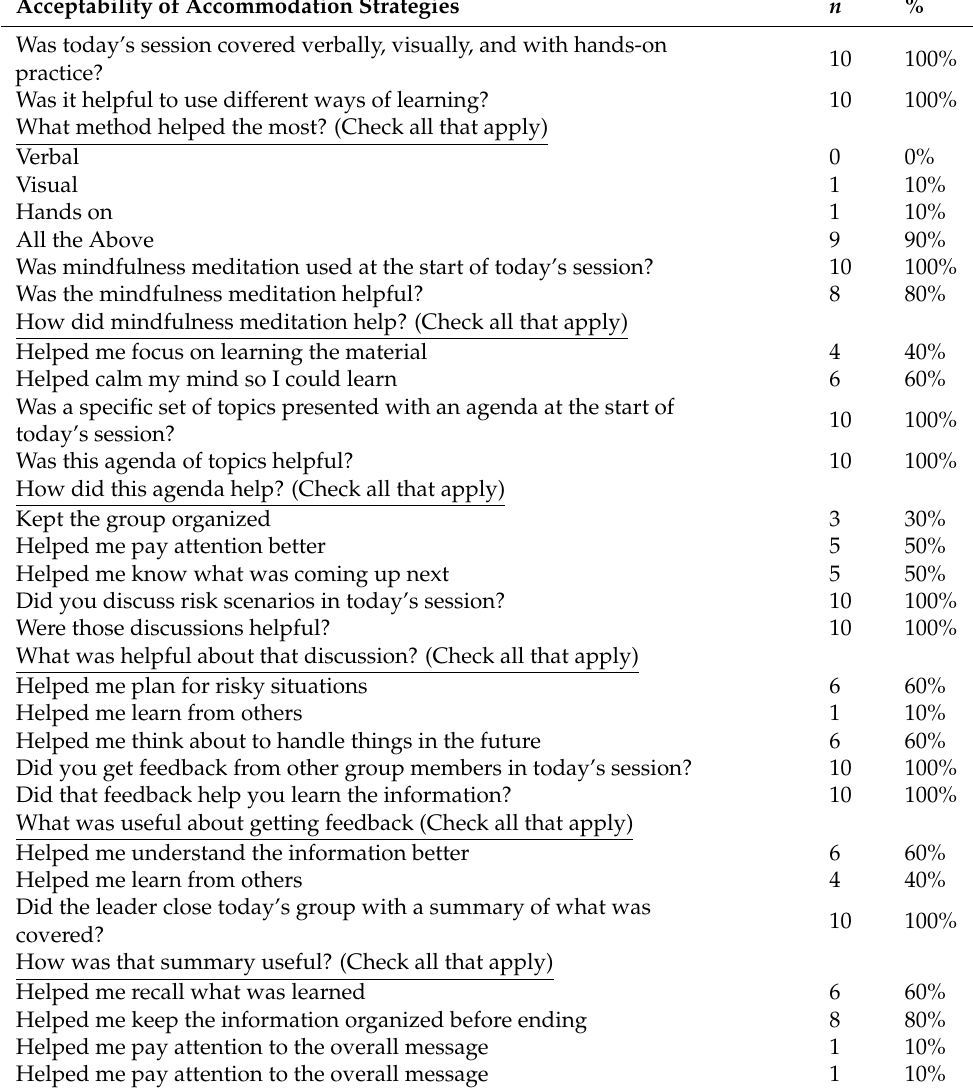
Table 3. Acceptability of accommodation